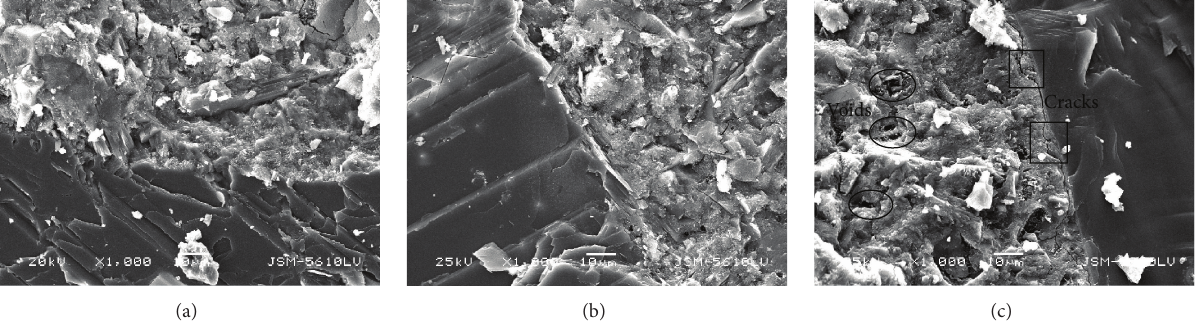
Figure 4: SEM images of ITZ in C60 CSC: (a) the control; (b) MB value 1.0; (c) MB value 2.0.